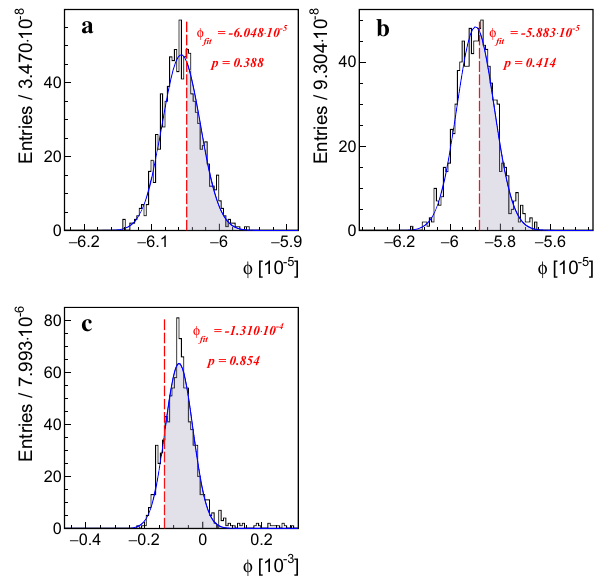
Fig. 10 Goodness of fit. Statistical energy φ distribution and corre- sponding p-value for ¯ pp → a π 0 π 0 η , b π 0 ηη and c K + K − π 0 . The red dashed line marks the position of the nominal statistical energy φ fit andthegrayareaillustratesthenumberofscenarioswithenergiesabove φ